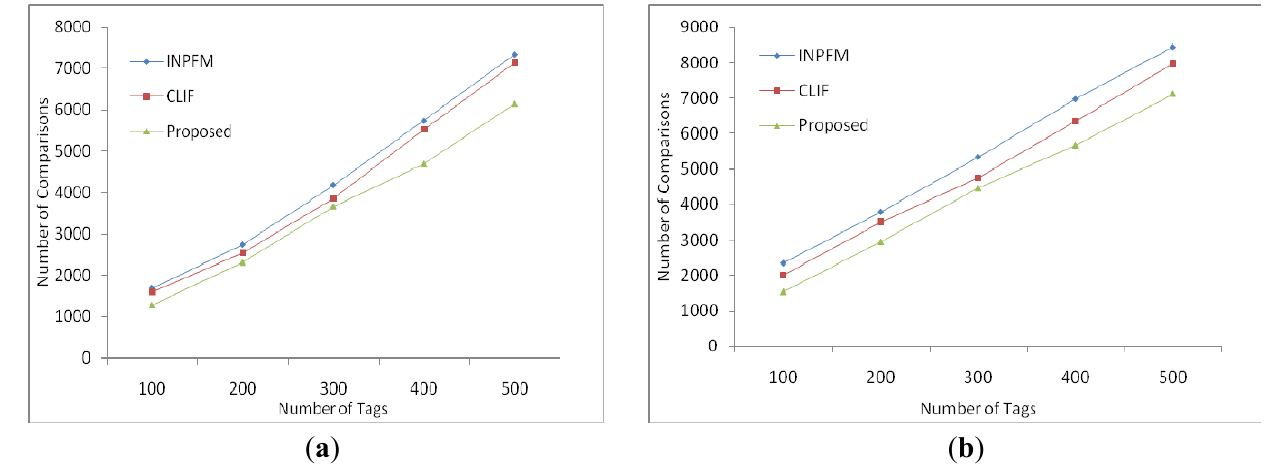
Figure 9. Computational cost in terms of number of comparisons required to filter data: ( a ) Sparsely disseminated tags with duplicate ratio 20%; ( b ) Densely disseminated tags with duplicate ratio 50%.